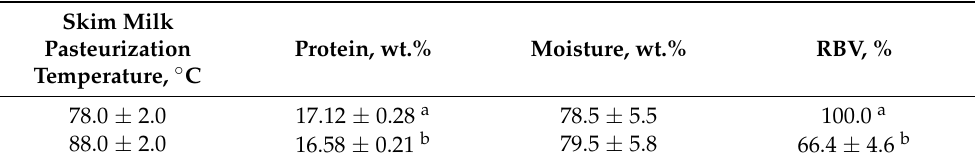
Table 3. Physical, chemical, and biological properties of acid curd samples. Protein and RBV mass fractions at different temperatures showed a statistically significant difference (marked with different superscript letters).